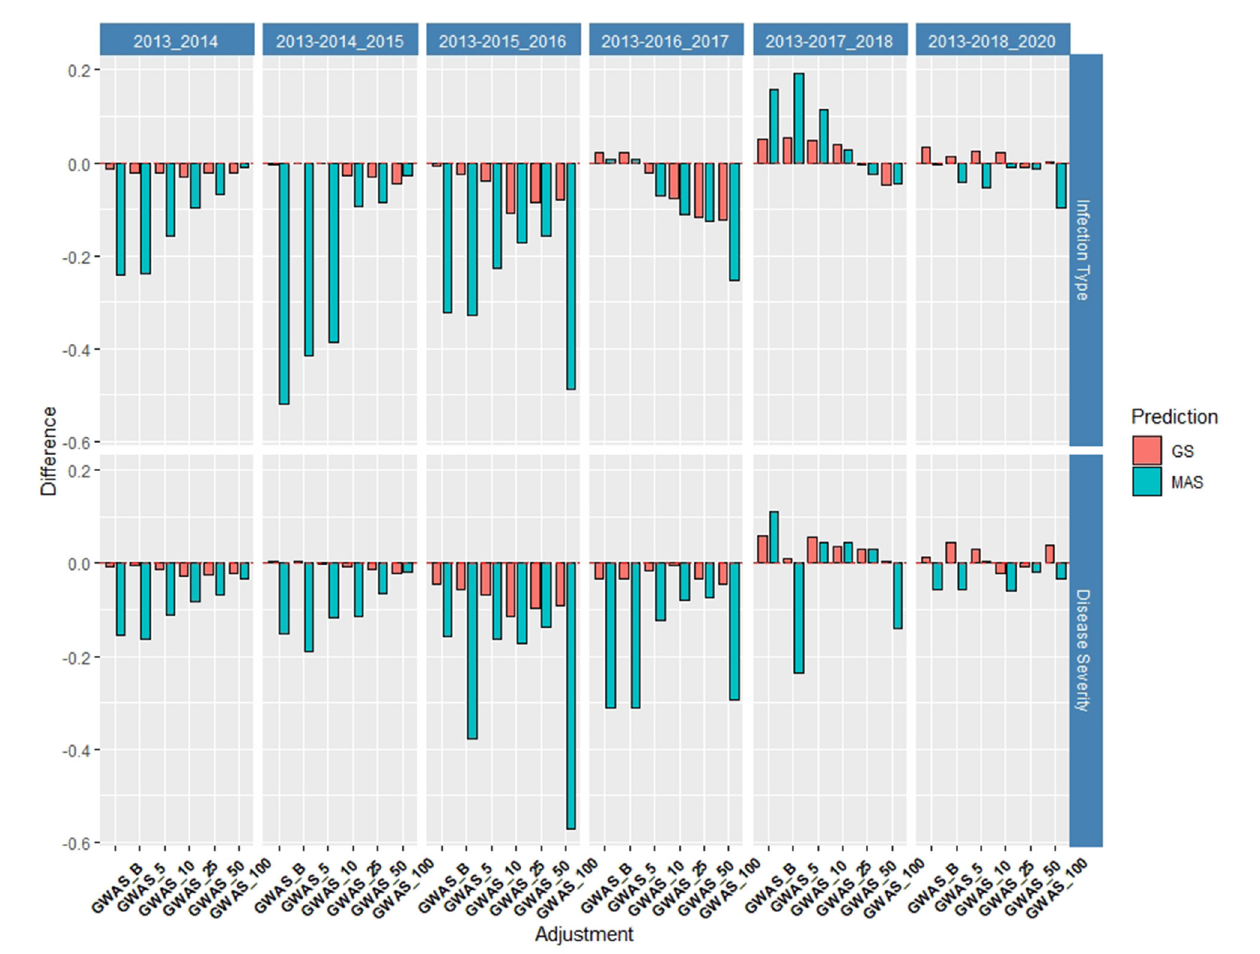
FIGURE 9 | Difference in prediction accuracy from the base rrBLUP model for de novo GWAS markers in GS and MAS in the validation set using the diversity panel (DP) lines and breeding lines (BL) phenotyped from 2013 to predict 2020. Adjustments: GWAS_B, GWAS-GS with Bonferonni significant markers; GWAS_5, GWAS-GS with the top five significant markers; GWAS_10, GWAS-GS with the top 10 significant markers; GWAS_25, GWAS-GS with the top 25 significant markers; GWAS_50, GWAS-GS with the top 50 significant markers; GWAS_100, GWAS-GS with the top 100 significant